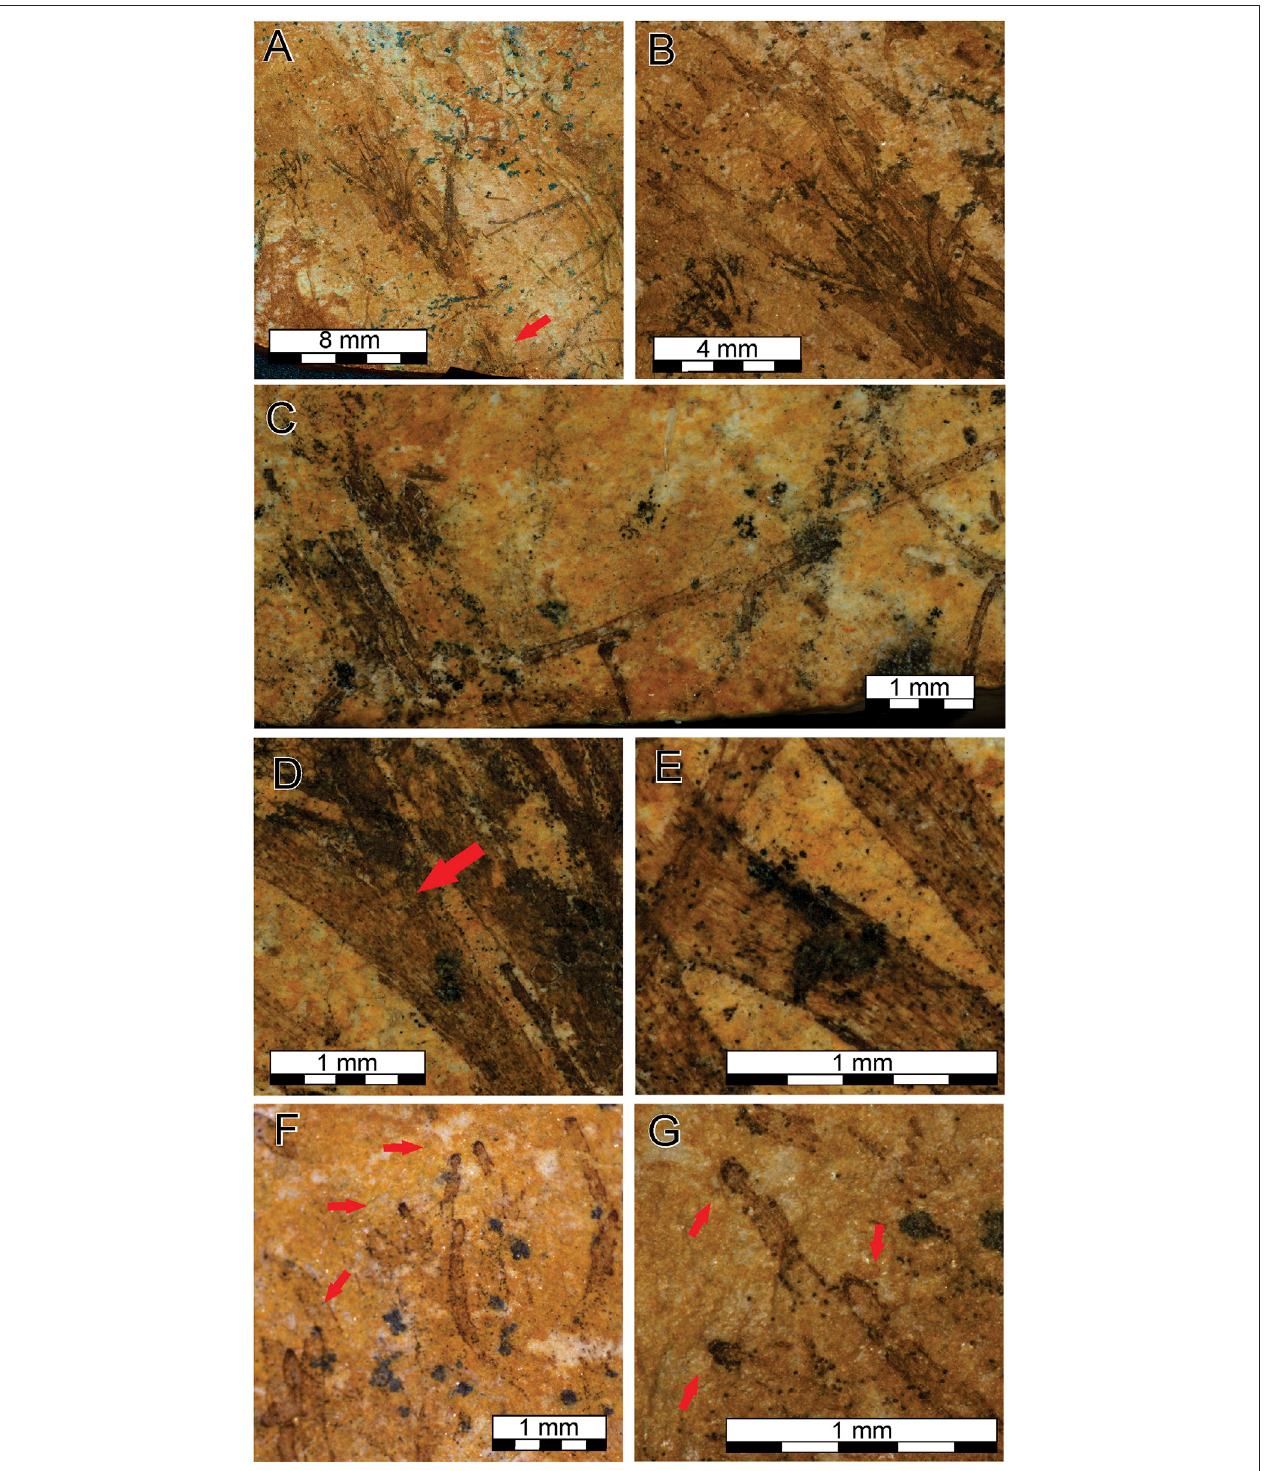
FIGURE 3 | Ladariella hidria . (A,B) Complete fossil with the arrow pointed out to the rhizoidal holdfasts in (A) . (C) Details of the rhizoidal holdfasts. (D) Branching (arrow). (E) Details of the striation in the thalli. (F,G) Details of the almond structure (arrows).